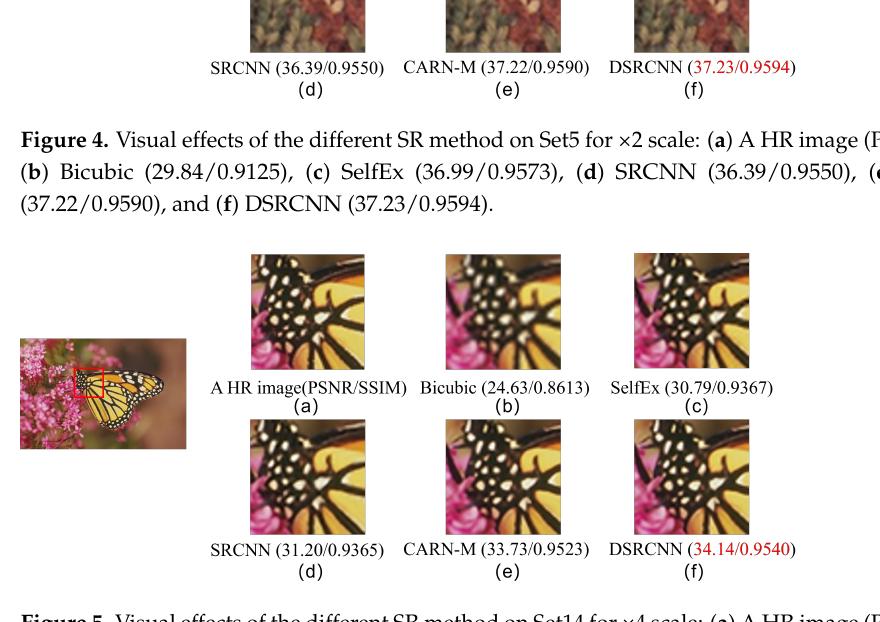
Figure 5. Visual effects of the different SR method on Set14 for ×4 scale: ( a ) A HR image (PSNR/SSIM), ( b ) Bicubic (24.63/0.8613), ( c ) SelfEx (30.79/0.9367), ( d ) SRCNN (31.20/0.9365), ( e ) CARN-M (33.73/0.9523), and ( f ) DSRCNN (34.14/0.9540).